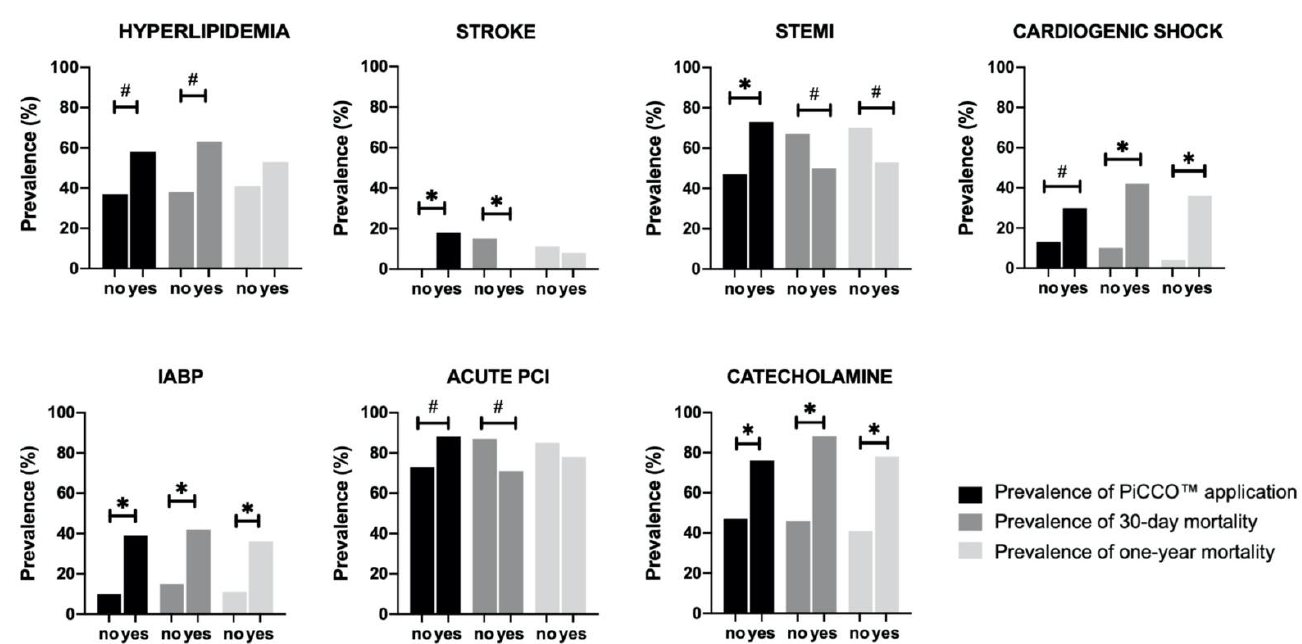
Figure 4. Comparison of PiCCO use, 30 day mortality, and 1 year mortality by patient condition characteristics. Chi-square test was performed. ∗ : p < 0.05; #: p < 0.2; PiCCO: pulse index contour cardiac output; IABP: intra-aortic balloon pump; PCI: percutaneous coronary intervention; and STEMI: ST-elevation myocardial infarction.